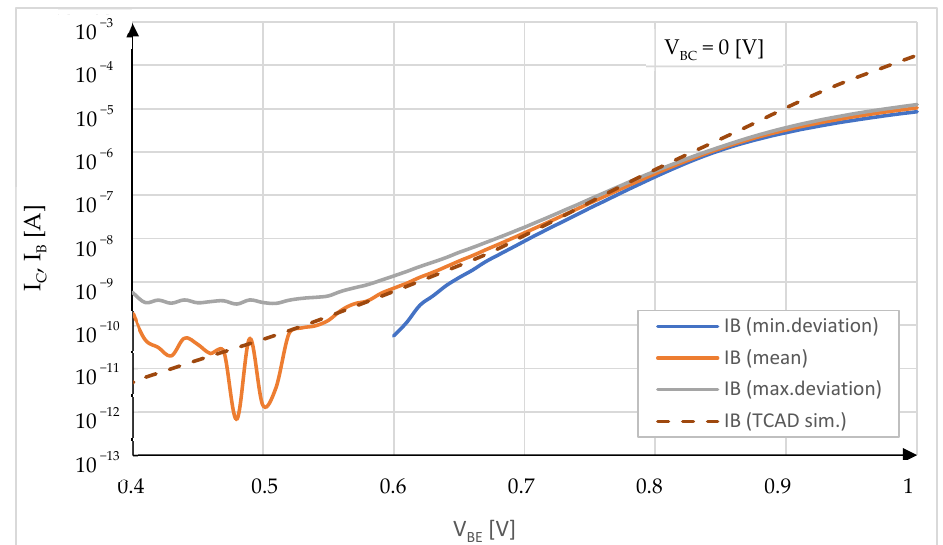
Figure 16. Comparison of measured base current statistics with TCAD simulation results (dashed line), the solid lines show the averaged results, and the upper and lower solid lines are the bounds of the standard deviation value.